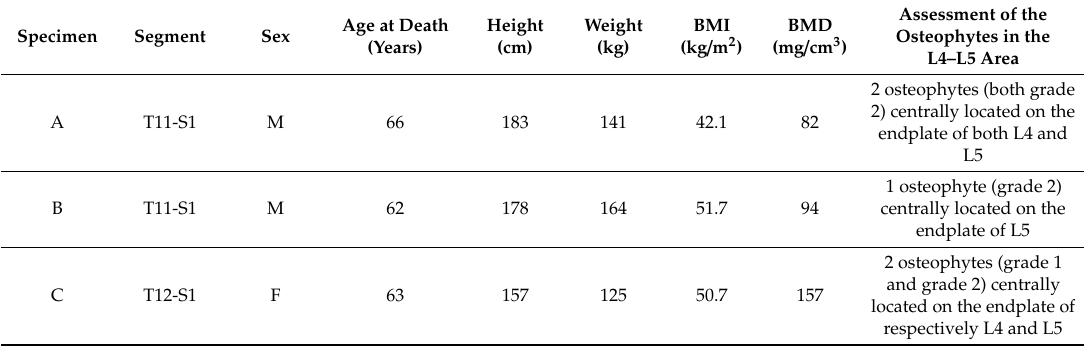
Table 1. Details of the specimens with the donor’s information. The last column reports the grading of the osteophytes (scored according to